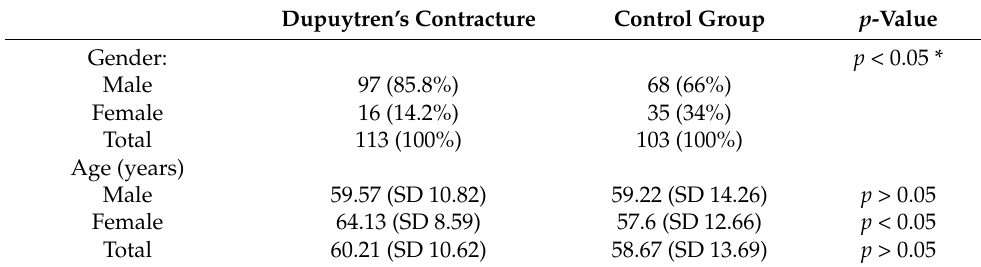
Table 1. Characteristics of study